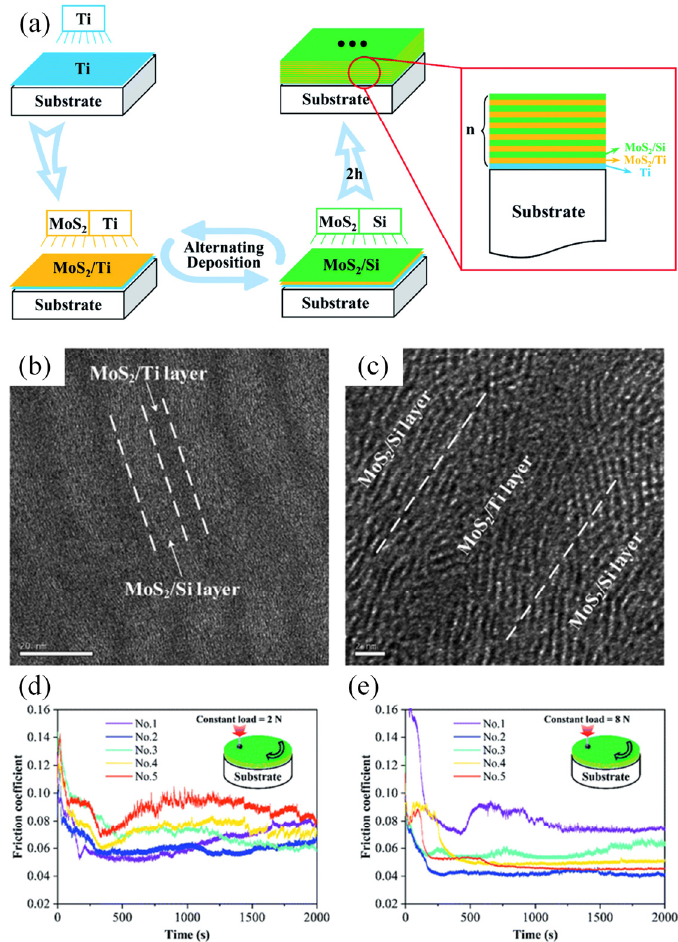
Figure 5. ( a ) Schematic diagram of the MoS 2 /Ti–MoS 2 /Si multilayer coating; ( b , c ) cross-sectional morphology of a MoS 2 /Ti–MoS 2 /Si multilayer coating; ( d , e ) COFs of different MoS 2 /Ti–MoS 2 /Si multilayer coatings under normal loads of 2 N and 8 N. Reprinted with permission from [103].